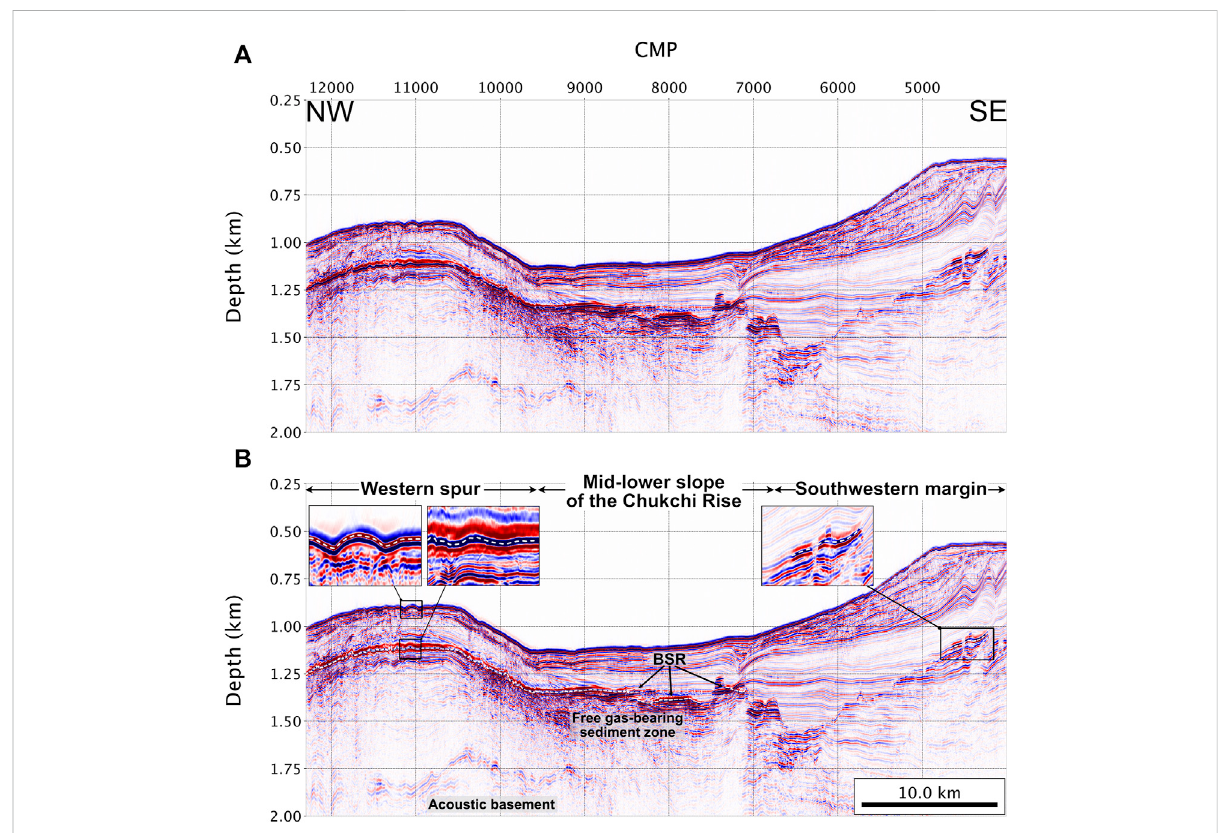
FIGURE 6 (A) Uninterpreted and (B) interpreted migrated seismic images obtained from the MCS03